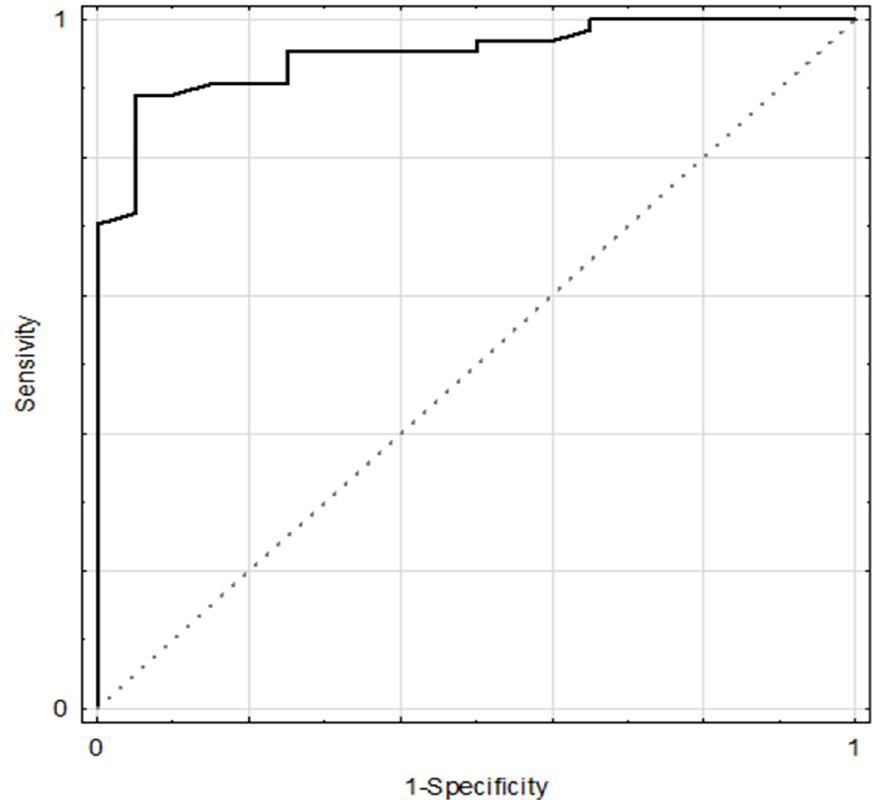
Figure 1. Receiver Operating Characteristic (ROC) curves for CLOCK level for the differentiation between one quarter (Q25) of CRY1 level and the rest group (sum of two, three, and four quarter CRY1 level subgroups) in the HT group—hypertensive individuals.